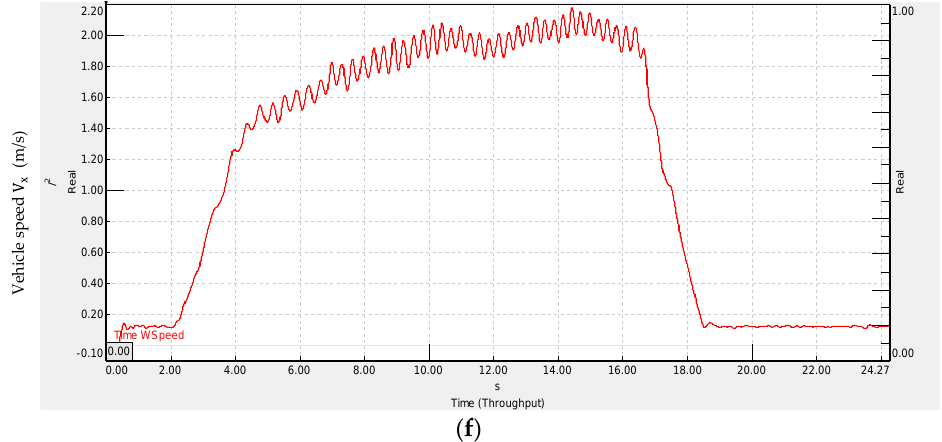
Figure 10. Test results at 2 m/s and 28 degrees steering input at cornering: ( a ) steering input by the driver; ( b ) tilt angle; ( c ) lateral translation acceleration ( 𝑦̈) ; ( d ) yaw rate; ( e ) actuator torque; and ( f ) vehicle speed.